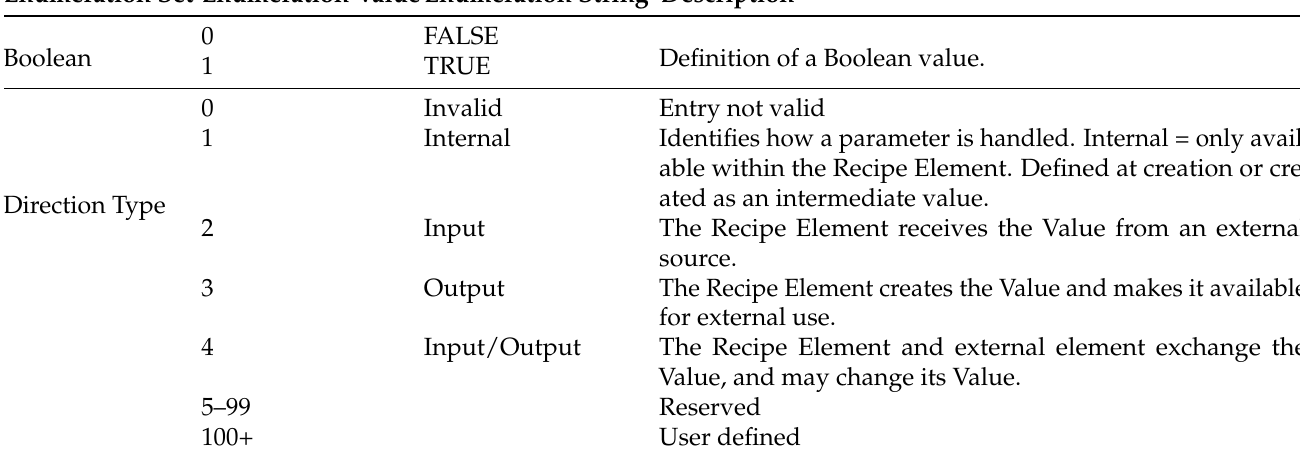
Table 9. ANSI/ISA standard properties for enumeration members.